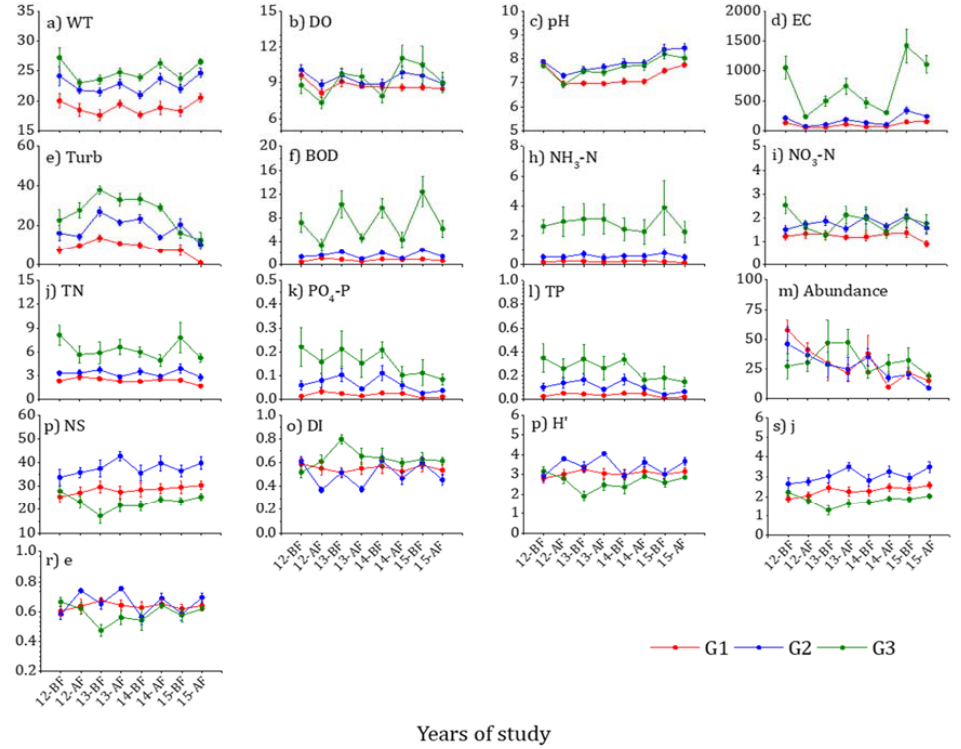
Figure 5. The temporal variability of the biological and physicochemical variables of each group (G1–3) in the Hantangang River, from 2012 to 2015. WT: water temperature (°C), DO: dissolve oxygen (mg/L), EC: electronic conductivity ( μ S/Cm), Turb: Turbidity (NTU), BOD: biochemical oxygen demand (mg/L), TN: total nitrogen (mg/L), TP: total phosphorus (mg/L), NH 3 ‐ N, NO 3 ‐ N, PO 4 ‐ P: mg/L, NS: number of species, BF: before monsoon, AF: after monsoon. DI; Dominance index, H’; Diversity index, j; Richness index, e; Evenness index, 12 ‐ BF and 12 ‐ AF: the measurements before and after monsoon in 2012, respectively.